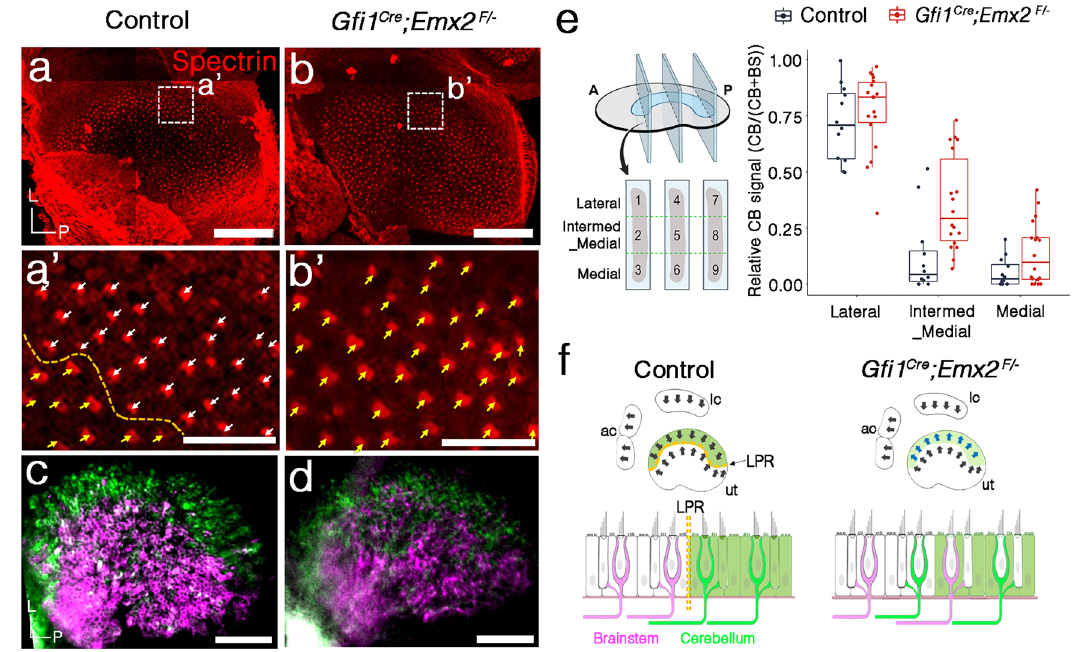
Fig. 3 | Minor disruption of neuronal innervation pattern in HC-speci fi c Emx2 KO. a – b ’ Hair bundle orientation across the LPR (yellow dotted line) of control ( a , a ’ ) is missing in the Emx2 cKO. Hair bundle orientation in the lateral region of Emx2 cKO utricles is similar to its medial region ( b , b ’ , yellow arrows, n =4) and is reversedfromthelateralregionofcontrols( a , a ’ ,whitearrows, n =4). c , d Neuronal dye tracing from the cerebellum (green) and brainstem (magenta) are not well segregated in the Emx2 cKO utricles ( d , n =9) as in controls ( c , n =5). e Boxplot showing the quanti fi cation of the cb signal from the cerebellum over total signals from cerebellum and brainstem using z -stacks of confocal images in nine selected regions according to the “ Methods ” section. In control utricles, the relative cb signal is signi fi cantly higher in the lateral utricle (areas #1, 4, and 7) than the intermediate_medial (areas #2, 5, and 8) and the medial region (areas #3, 6, and 9) (Dunn ’ s pairwise tests, z =3.83, p =2.6E − 04; z =4.45, p =2.5E − 05). Similar decrease